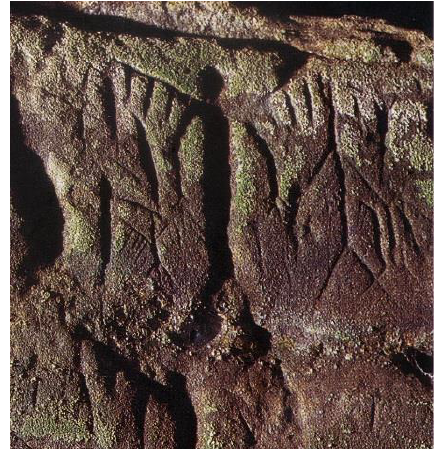
Figure 4. Abraded quasi-human